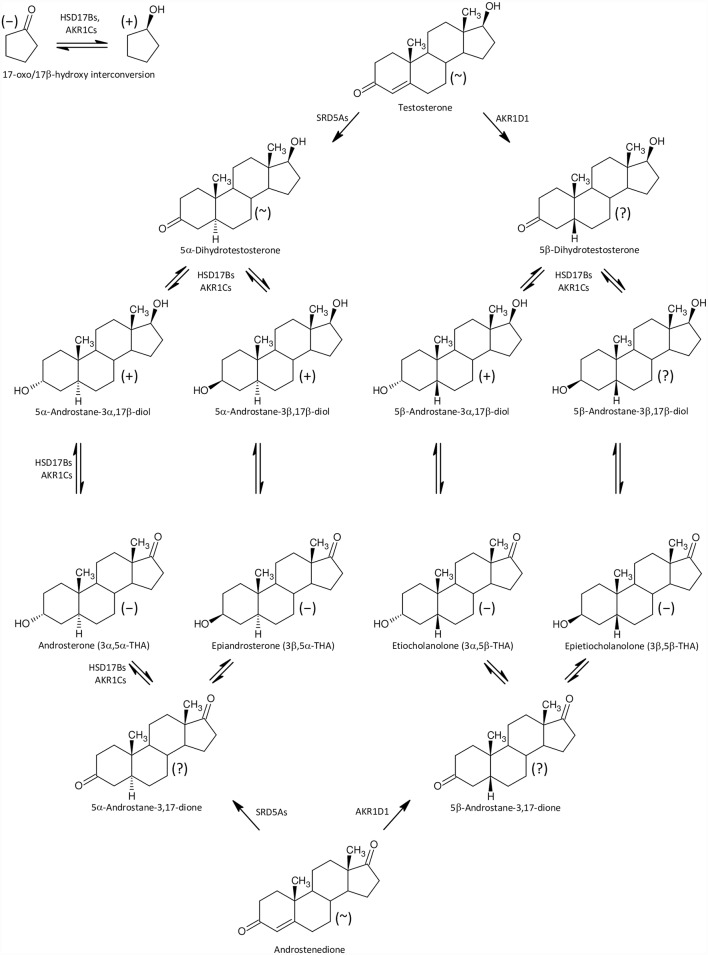
A simplified scheme of 5α/β-reduced C19 steroid biosynthesis in the human “frontdoor pathway”.The symbols in parentheses “+”, “~”, ”−“, and ”?” represent increased, unchanged, decreased and unknown steroids levels, respectively, in the ICP group.